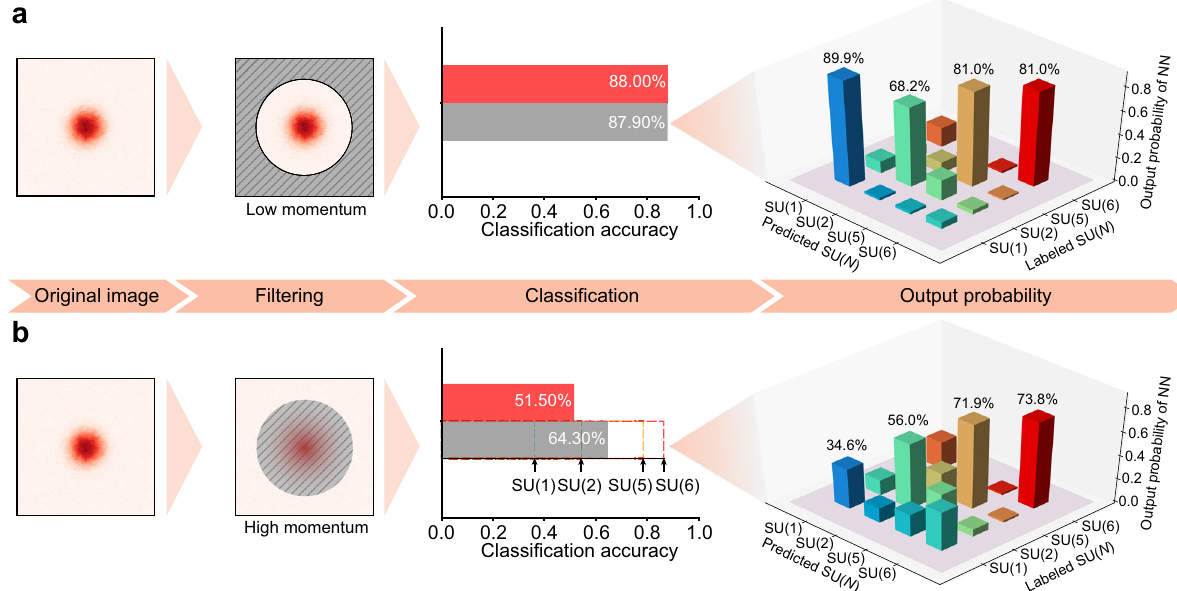
Fig. 3 In fl uence of low- and high-momentum parts on classi fi cation. Classi fi cation accuracy with neural networks trained only with low a and high b momentum parts. Red and gray bars represent the accuracy of pre-trained and re-trained NNs, respectively. Retraining of the neural networks with only high- or low-momentum parts enhances the accuracy as shown in gray bars. For high-momentum parts, classi fi cation accuracy increases with N as shown in black ticks in b , where the average of the four investigated SU( N ) cases is 64.30%. For the re-trained NN, the output probabilities of the NN are shown for input